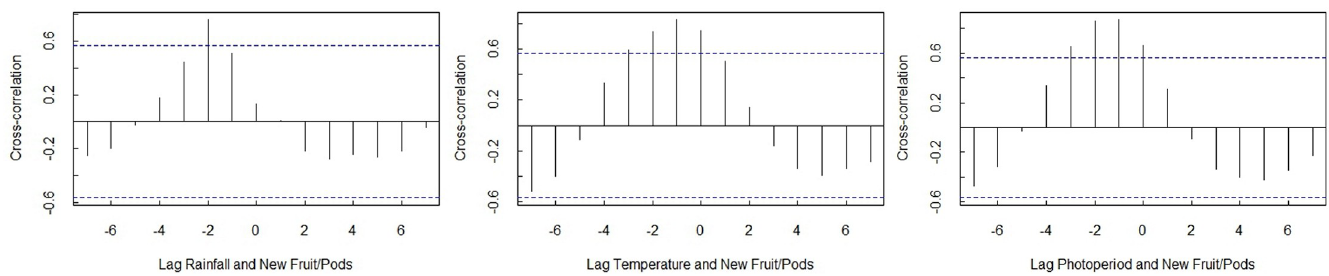
Fig 5. Correlogram indicating moderately significant lags between a) new fruit/pods and rainfall at position -2, b) new fruit/pods and temperature at position -1, and c) new fruit/pods and photoperiod at positions -2 and -1.